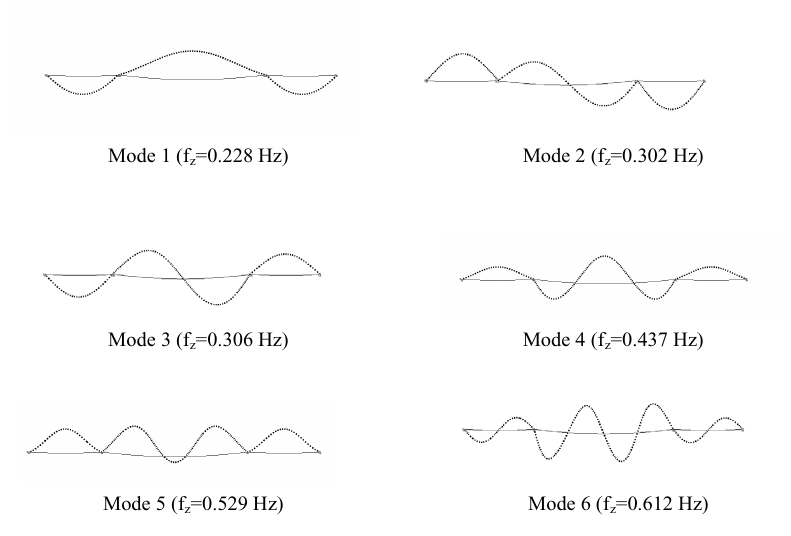
Fig. 6. Vibration modes of a three-span cable based on ABAQUS.